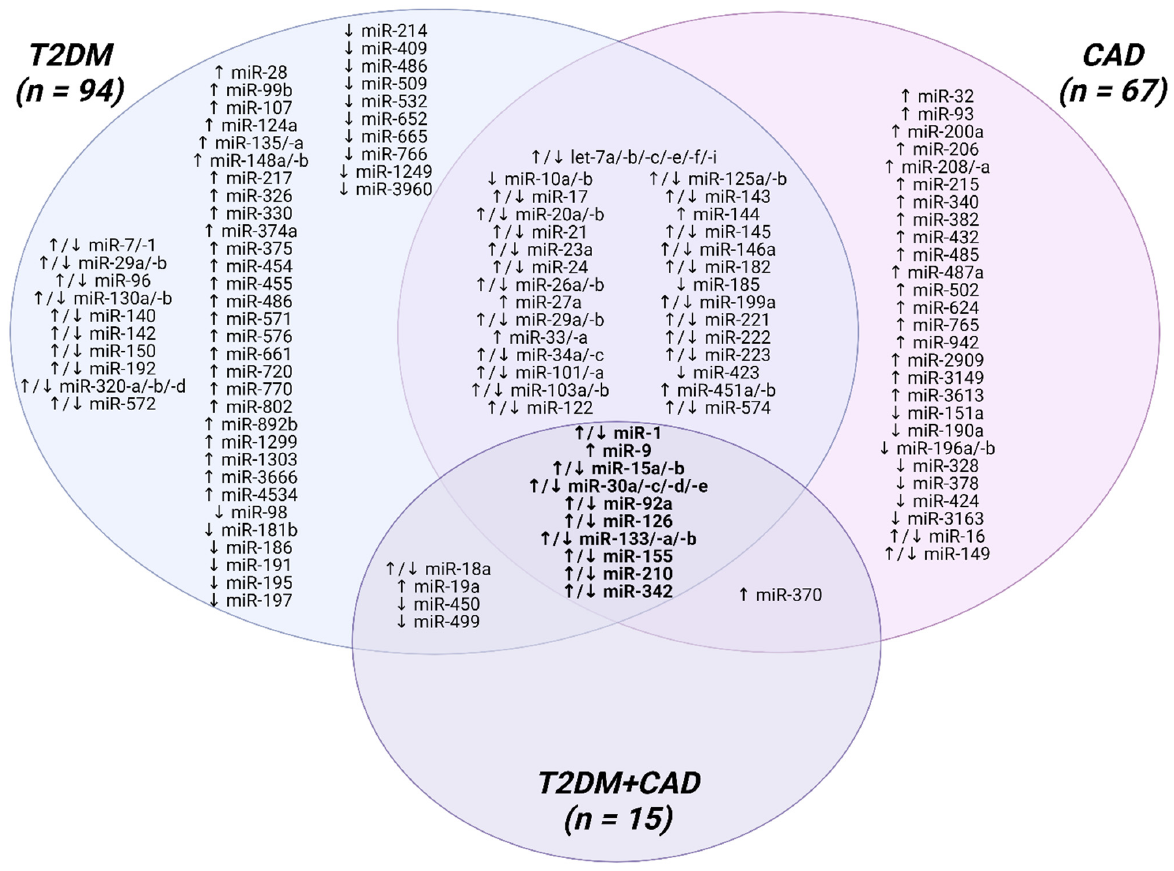
Figure 3. Venn diagram of differentially expressed microRNAs in patients with T2DM, CAD, and CAD related to T2DM. Overlapping fields indicate miRNAs that have been associated with two of these pathologies. In the center of the figure, ten miRNAs are highlighted with different expressions that have been detected in T2DM, CAD and T2DM with CAD. Created with